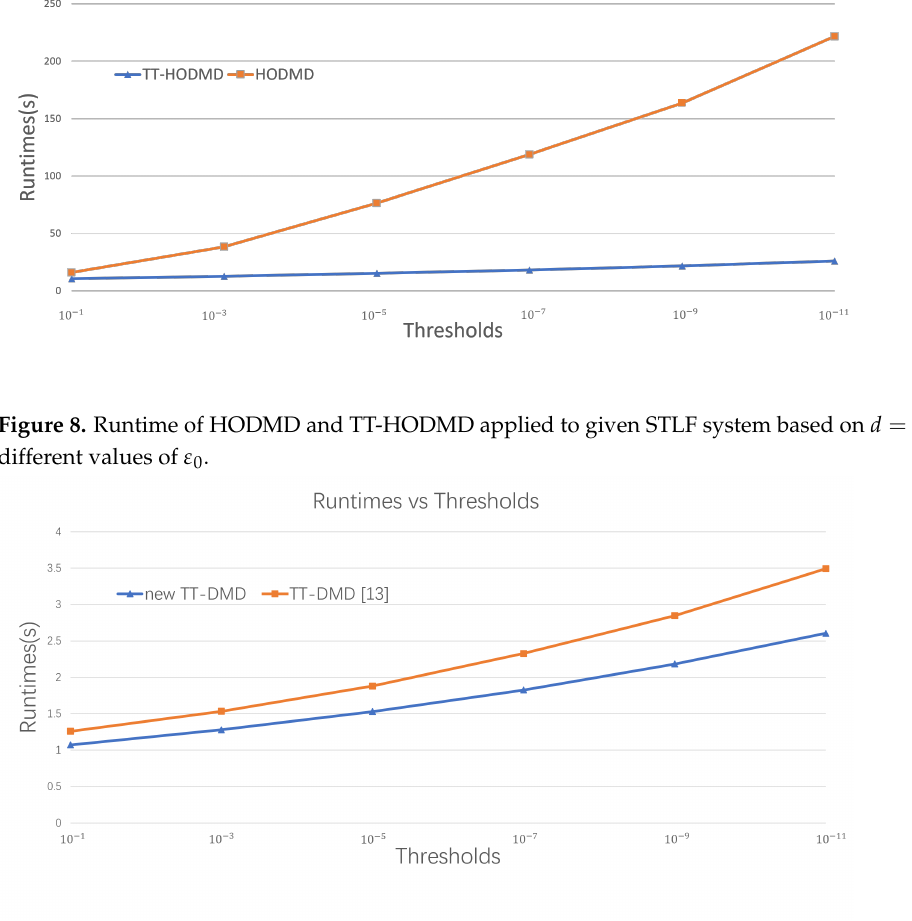
Figure 9. Comparison of the runtime of TT-DMD [14] algorithm and new TT-DMD algorithm applied to given STLF system for different values of